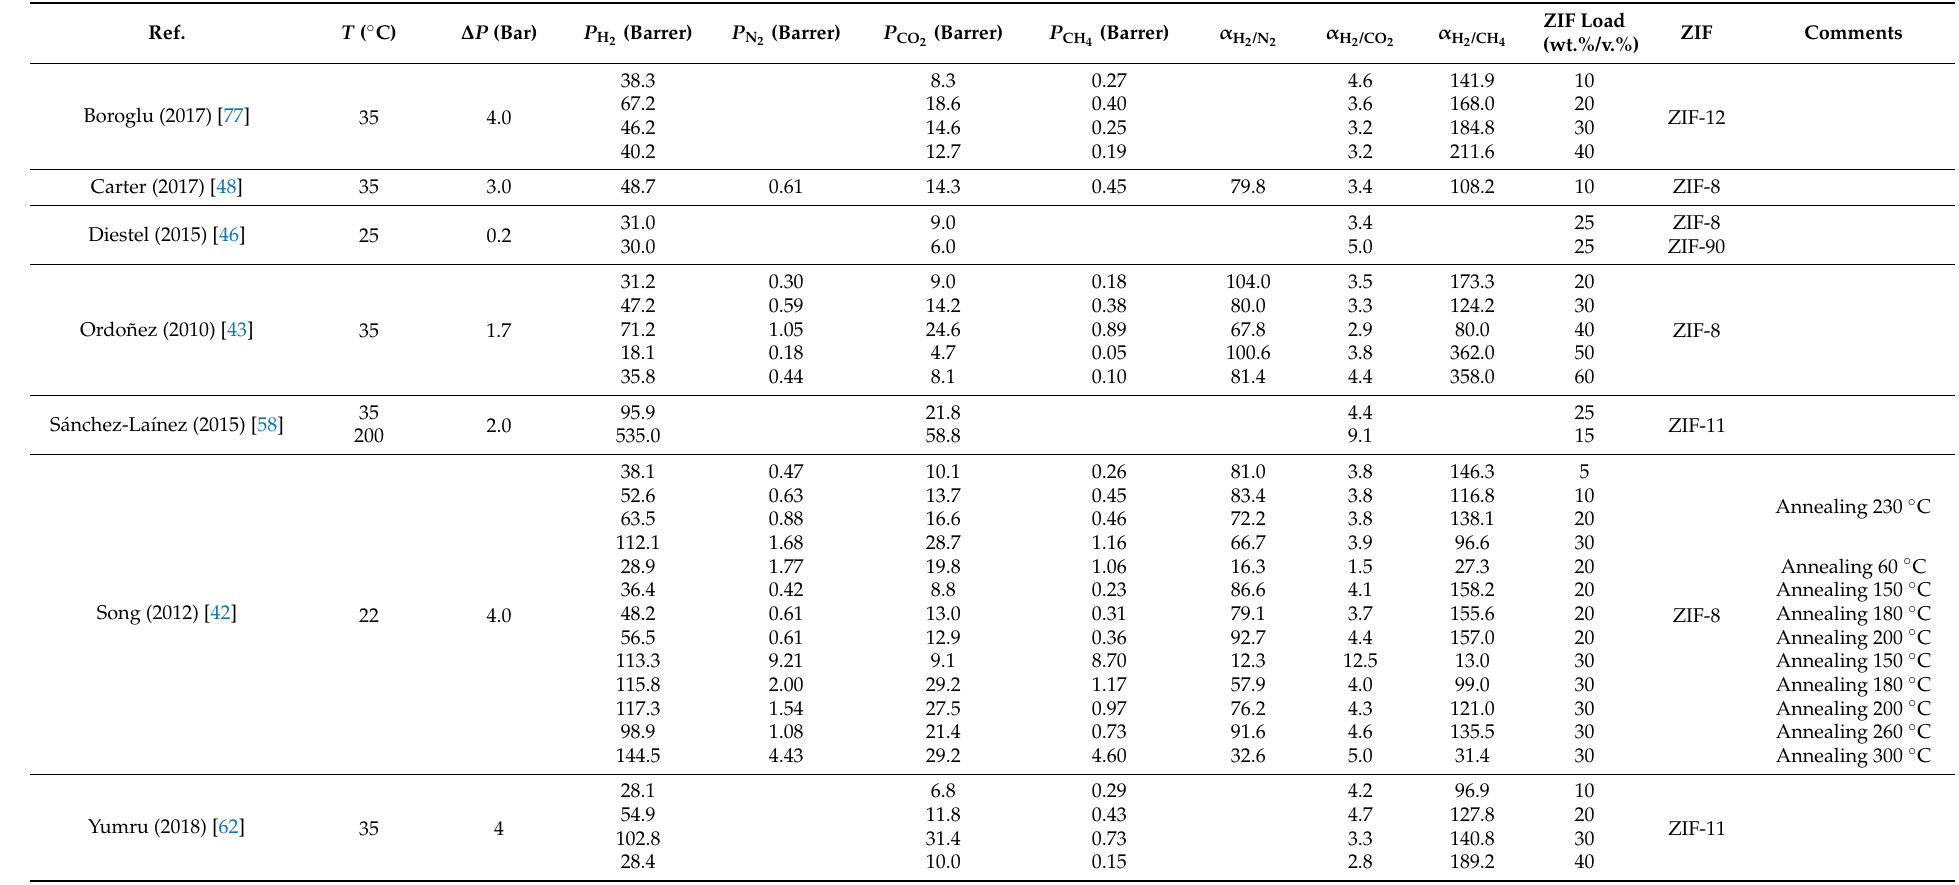
Table 4. Main bibliographical data in terms of pure gas H 2 , N 2 , CO 2 and CH 4 permeabilities and selectivities through Matrimid ® /ZIF MMMs.